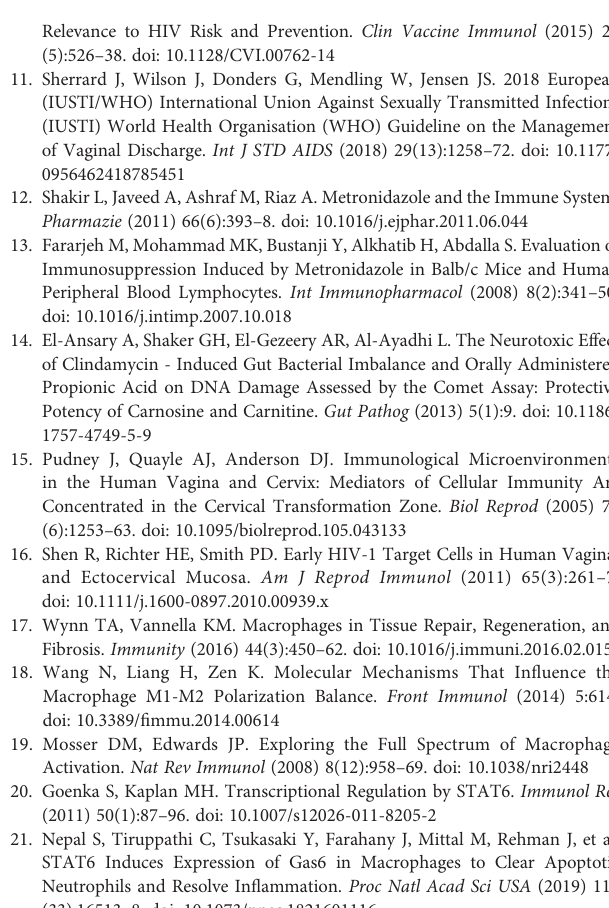
(A) Detection of phosphorylated NF k B p65 subunit (p-p65), STAT3 (p-STAT3), and STAT6 (p-STAT6) after 1 h treatment with the conditioned medium (CM) from TP4 (3.91 or7.82 m g/ml)-treated VK2cells to RAW264.7/GV cellsby immunoblotting. b - actin was used as an internal control to show equal protein loading. (B) The CM